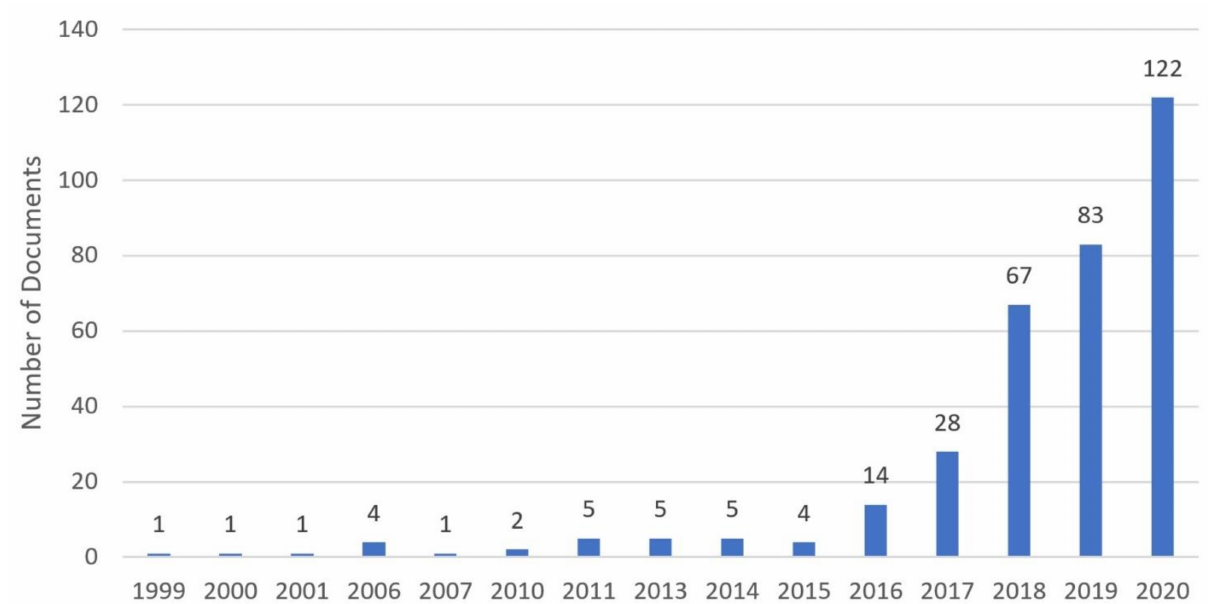
Figure 7. Publication trend of circular SCM. The keyword coexistence network on CSCM (Figure 8) focuses on ‘sustainability’, ‘waste management’, ‘recycling’, ‘environmental management’ in addition to ‘circular econ-